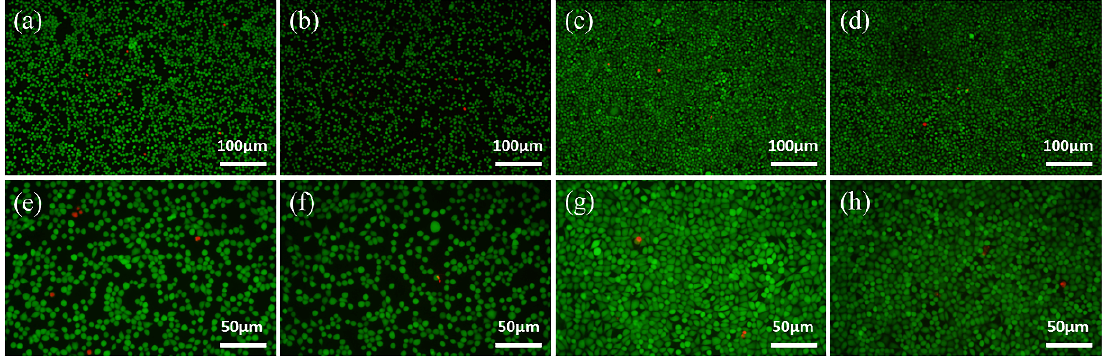
Figure 9. Fluorescence images of L-929 cells cultured on the samples for 24 h ( a , b , e , f ) and 48 h